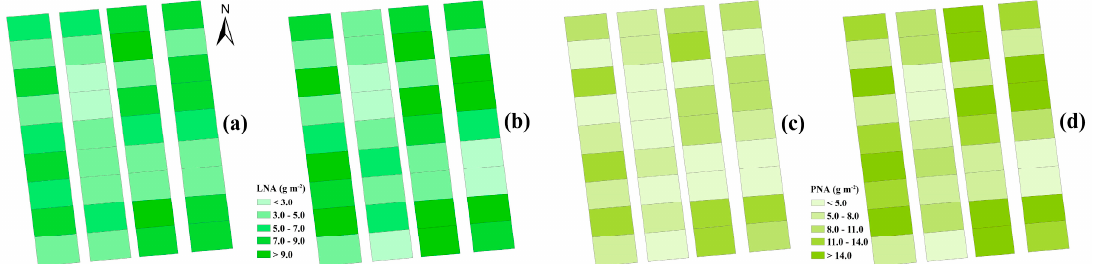
Figure 10. N accumulation maps using the derived generic relationship between CI red edge and N accumulation at different growth stages, LNA at jointing stage ( a ) and booting stage ( b ); PNA at jointing stage ( c ) and booting stage ( d